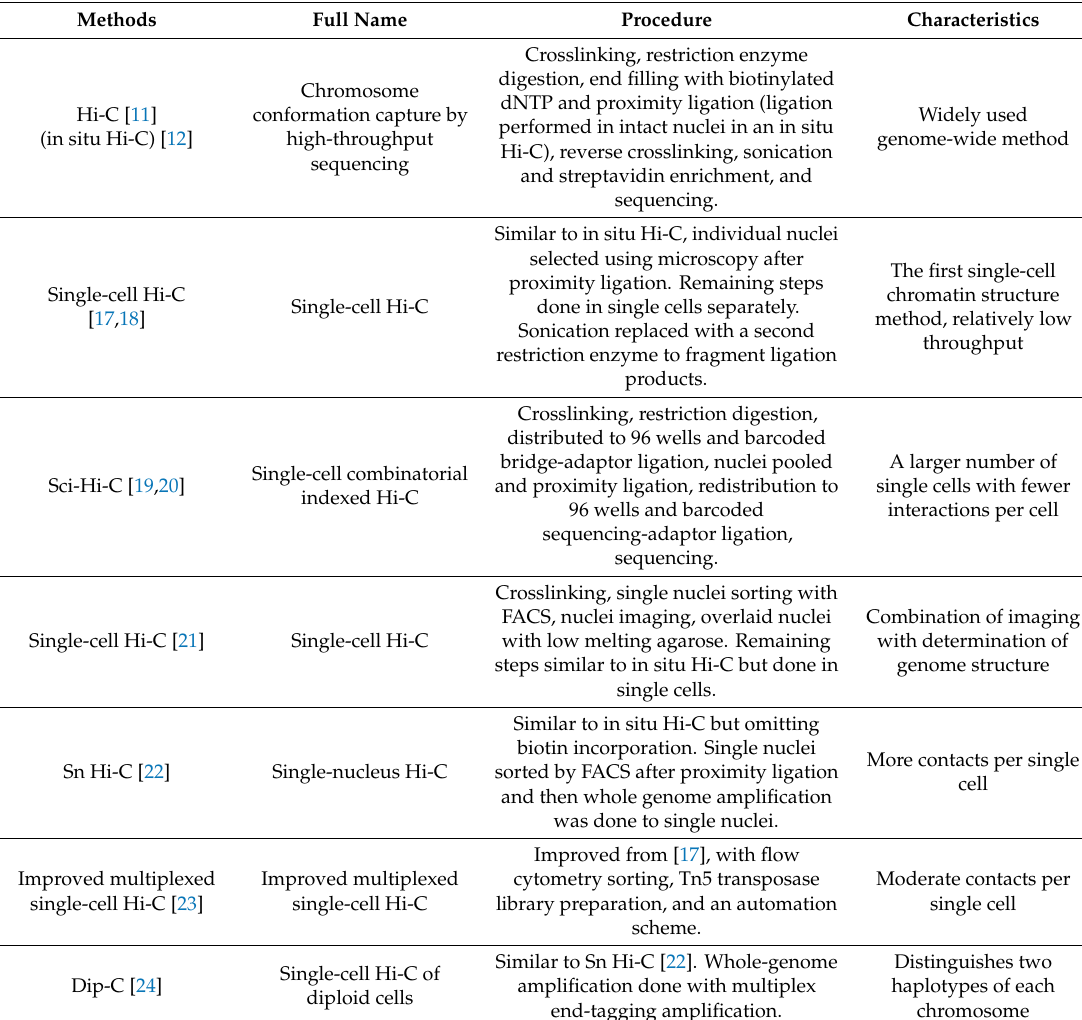
Table 1. Single-cell Hi-C techniques and